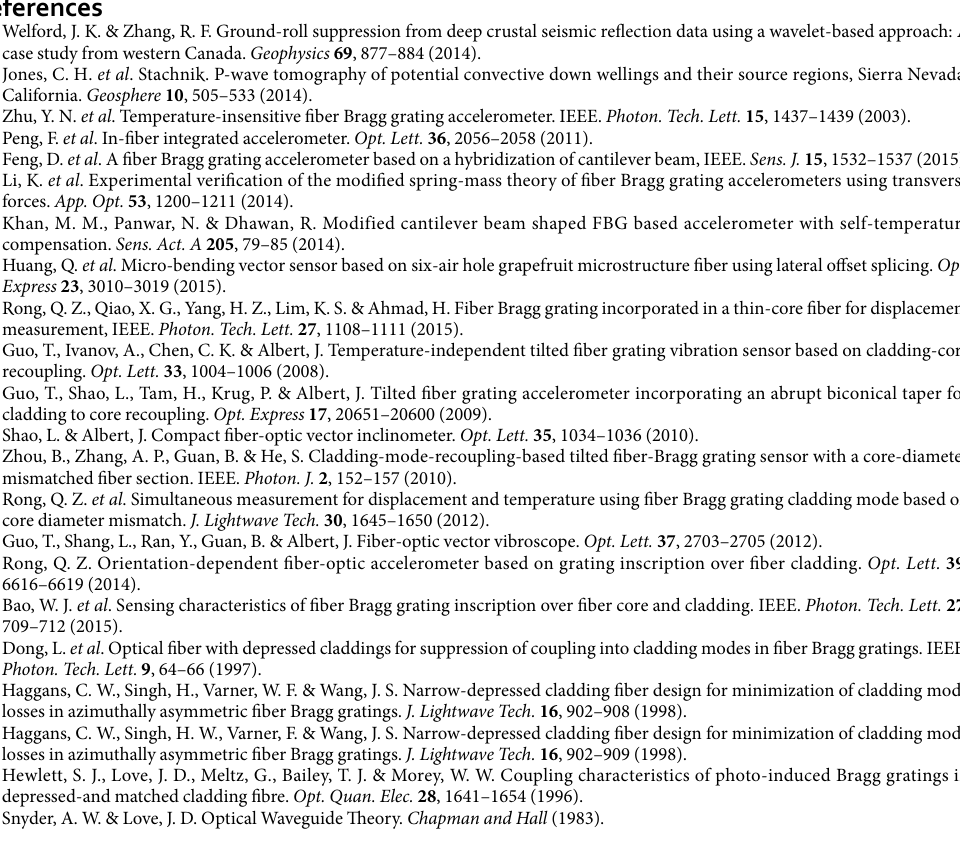
The average pulse energy of the laser output is fixed at 0. 5 mJ (controlled by an optical attenuator). The femto- second laser beam is precisely focused along the core, then gratings in fiber core and core dip can be achieved simultaneously. Strong laser energy of Femtosecond laser (highly localized nonlinear light-material interaction) and photon-sensitivity of selected DCF contributes to this grating inscription. The exposure time lasts only 2 sec- onds (i.e. 2000 times laser pulses). Because of the fixed period of phase mask used in the experiment, the reso- nance spectrum of fundamental mode is posited at the wavelength close to 1550 nm. The DCF-FBG is spliced in a conventional fusion splicer after core alignment of two fibers. To avoid the fiber end-face reflection’s influence to resonance spectrum, the state of the sensing end-face is always keeping roughness. In order to interrogate the device, non-polarized light is injected to the grating by a tunable laser source with wavelength range from 1500 to 1600 nm, the spectrum of the sensor is detected by an optical spectrum analysis (OSA), and the dynamic power fluctuation of the sensor is detected by a power detector following with an oscilloscope.